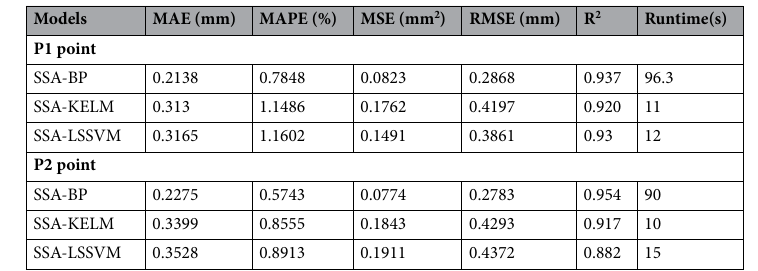
Table 15. Evaluation indicators of three models under P1 and P2 monitoring points.